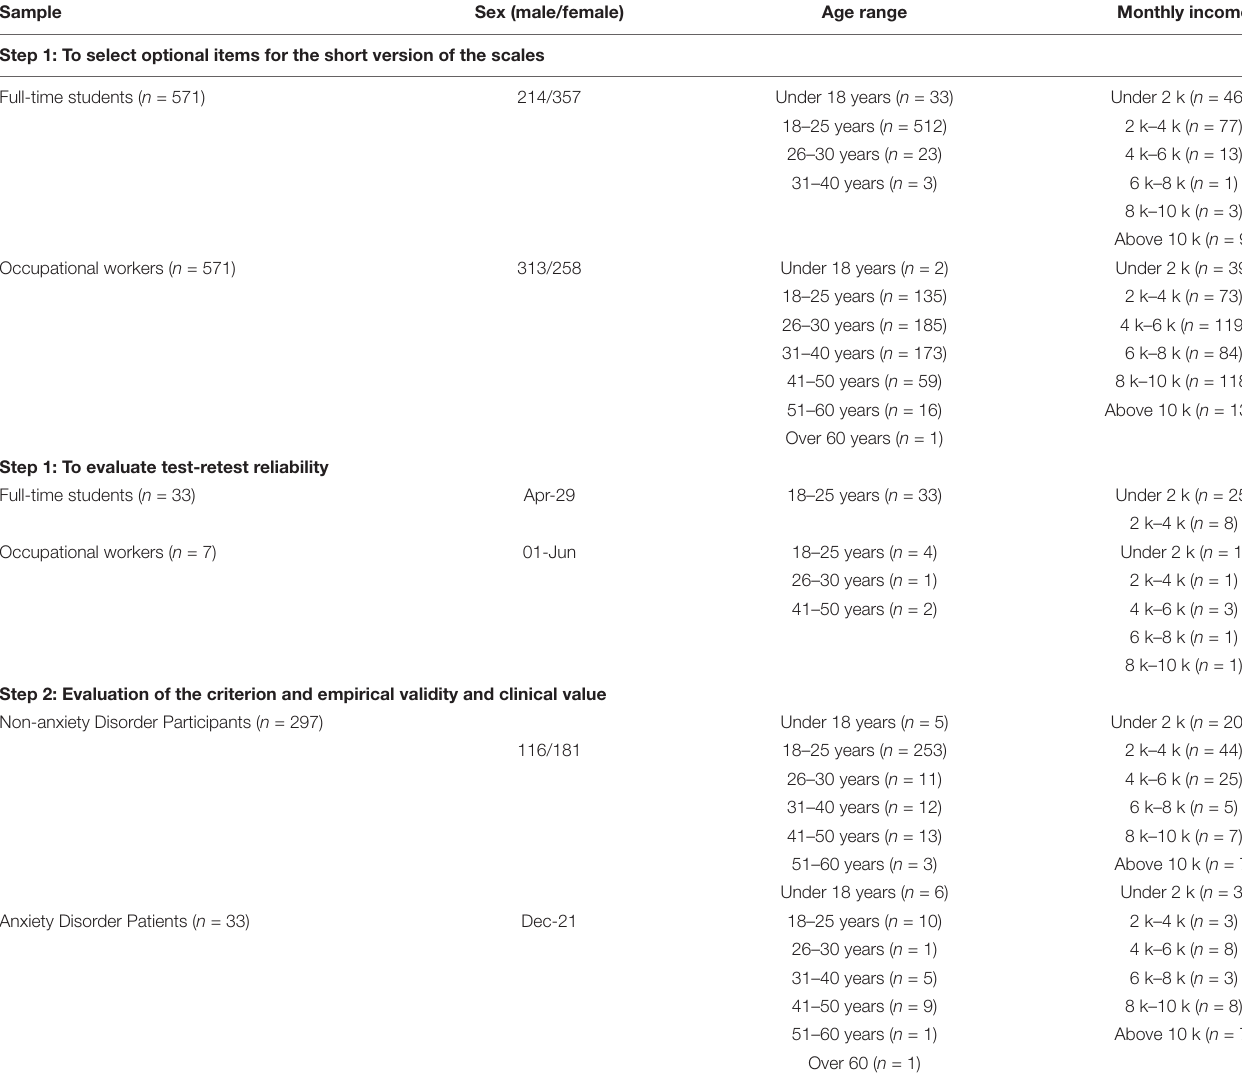
TABLE 1 | Demographic data of the participants in the present study.